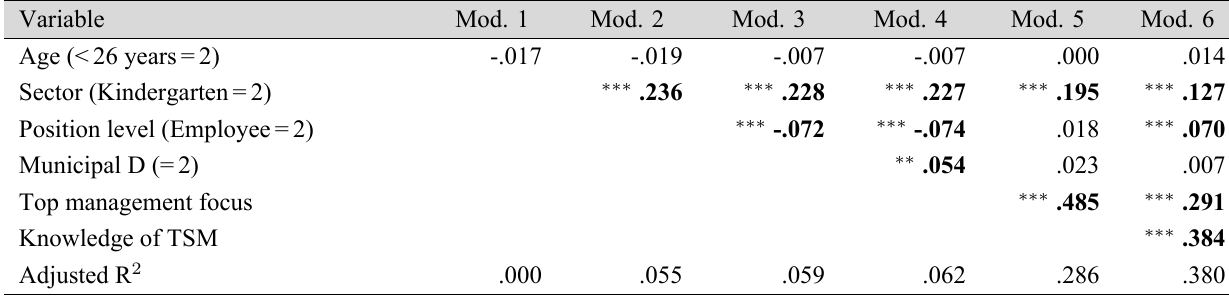
Table 5 Linear regression. Dependent variable: ‘Perceived improvements in municipal traffic safety culture of being approved as a Traffic Safe Municipality’. Standardized beta coefficients.